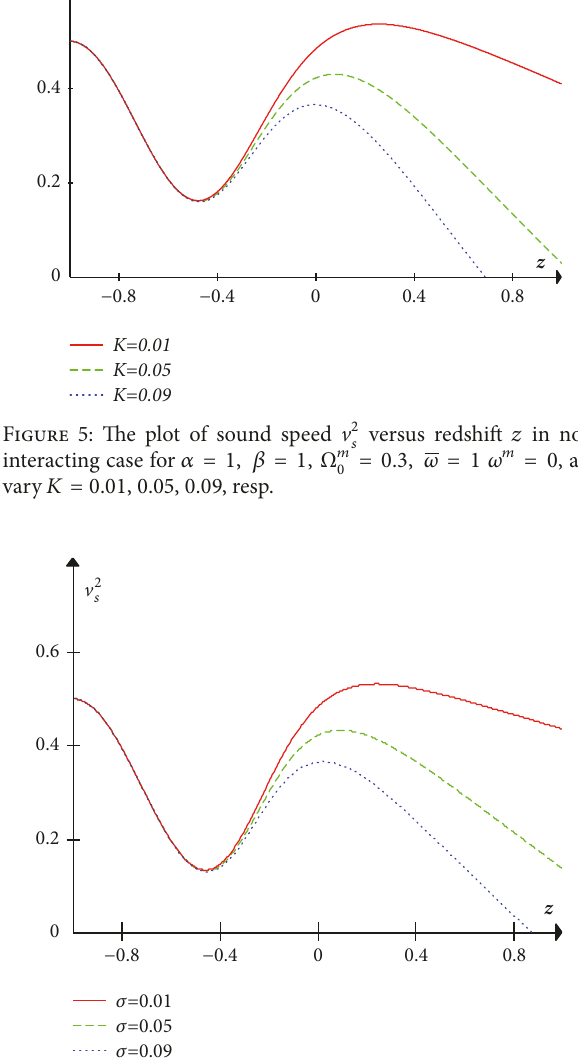
Figure 6: The plot of sound speed V 2 𝑠 versus redshift 𝑧 in interacting case for 𝛼 = 1, 𝛽 = 1 , Ω 𝑚 0 = 0.3, 𝜔 = 1 , 𝜔 𝑚 = 0, 𝐾 = 0.01 , and vary 𝜎 = 0 .01, 0.05, 0.09,